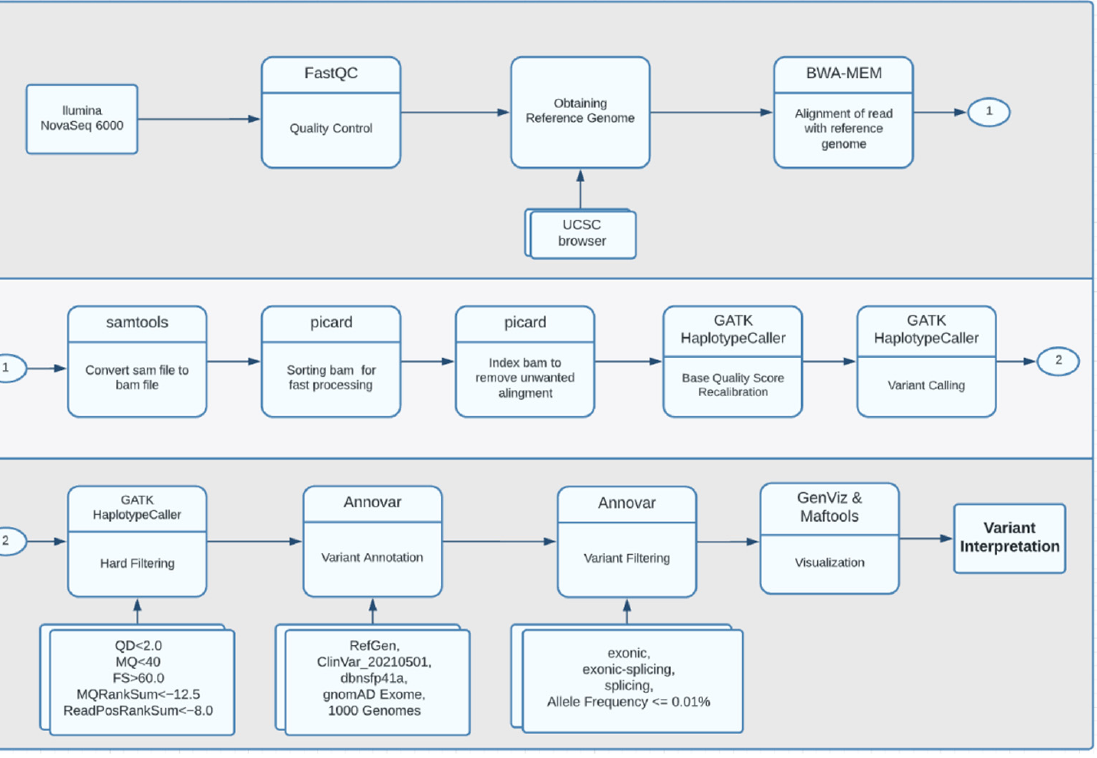
Figure 2. Whole-exome sequencing analysis workflow.